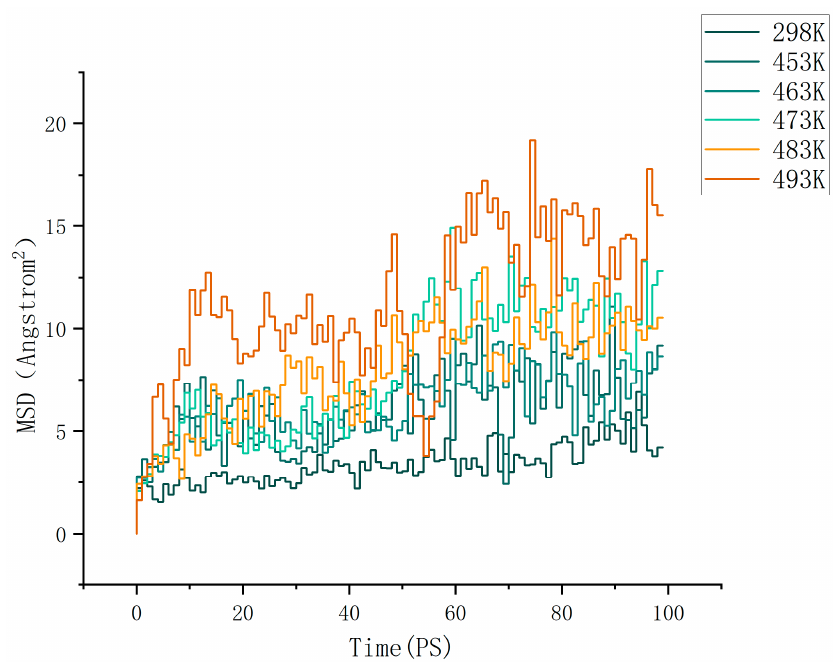
Figure 4. MSD of cellulose–formaldehyde